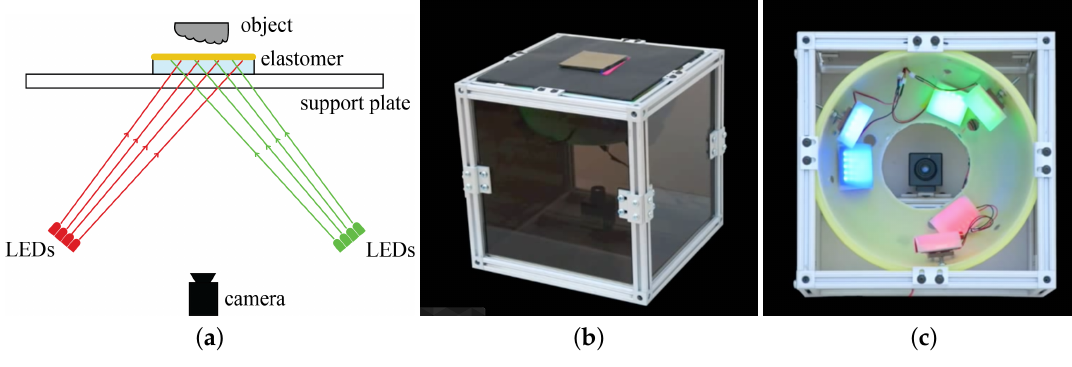
Figure 2. ( a ) basic principle of the Gelsight and the desktop design introduced in [7]. There are four main components for the GelSight sensor: an sensing elastomer piece with the opaque reflective membrane on top, supporting plate, LEDs which provide illumination, and the camera in the bottom to capture the shaded images under the illumination from different directions; ( b ) shows the picture of the sensor, and ( c ) shows the arrangement of the LEDs and camera when viewing from the